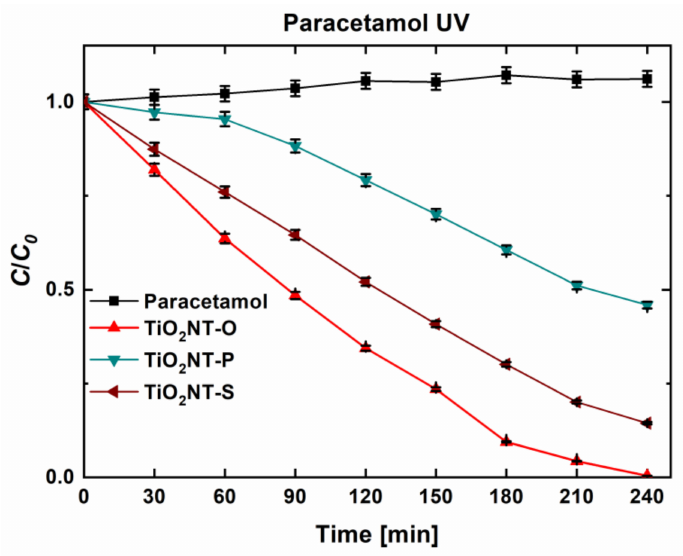
Figure 8. Degradation efficiency of nanotube arrays towards paracetamol after irradiation with UVA